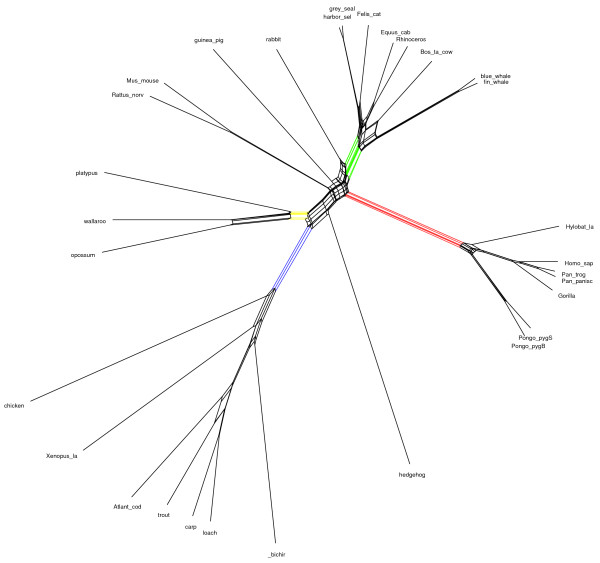
The N-Net network for the Mammal data set.